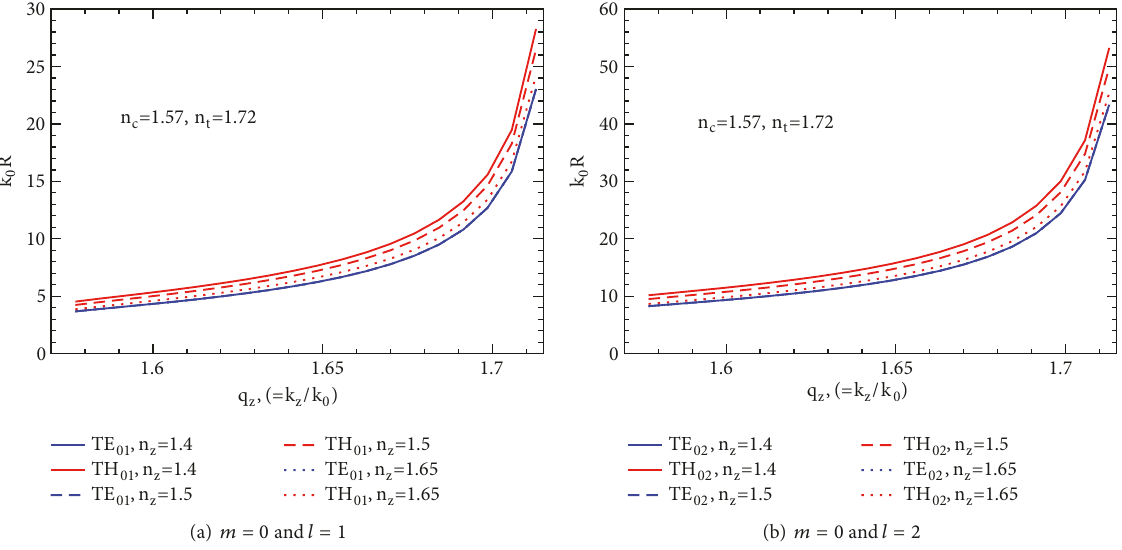
Figure 1: Dependence of the dimensionless parameter 𝑘 0 𝑅 ≡ 𝜔𝑅/𝑐 on 𝑞 𝑧 = 𝑘 𝑧 /𝑘 0 for TE 𝑚𝑙 ( 𝐸 𝑧 = 0 ) and TH 𝑚𝑙 ( 𝐻 𝑧 = 0 ) waves with 𝑚 = 0 : (a) 𝑙 = 1 and (b) 𝑙 = 2 (index 𝑙 enumerates the branches of roots in ascending order) at different values of the refractive index 𝑛 𝑧 .